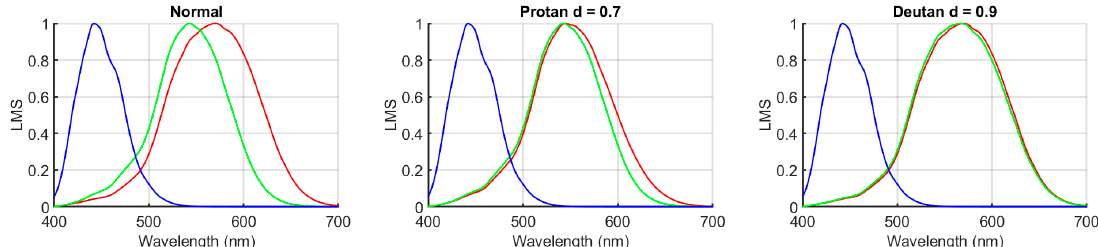
Figure 4. LMS cone response functions simulated for normal ( left ), protanomalous d = 0.7 ( center ), and deuteranomalous d = 0.9 ( right ) observers.